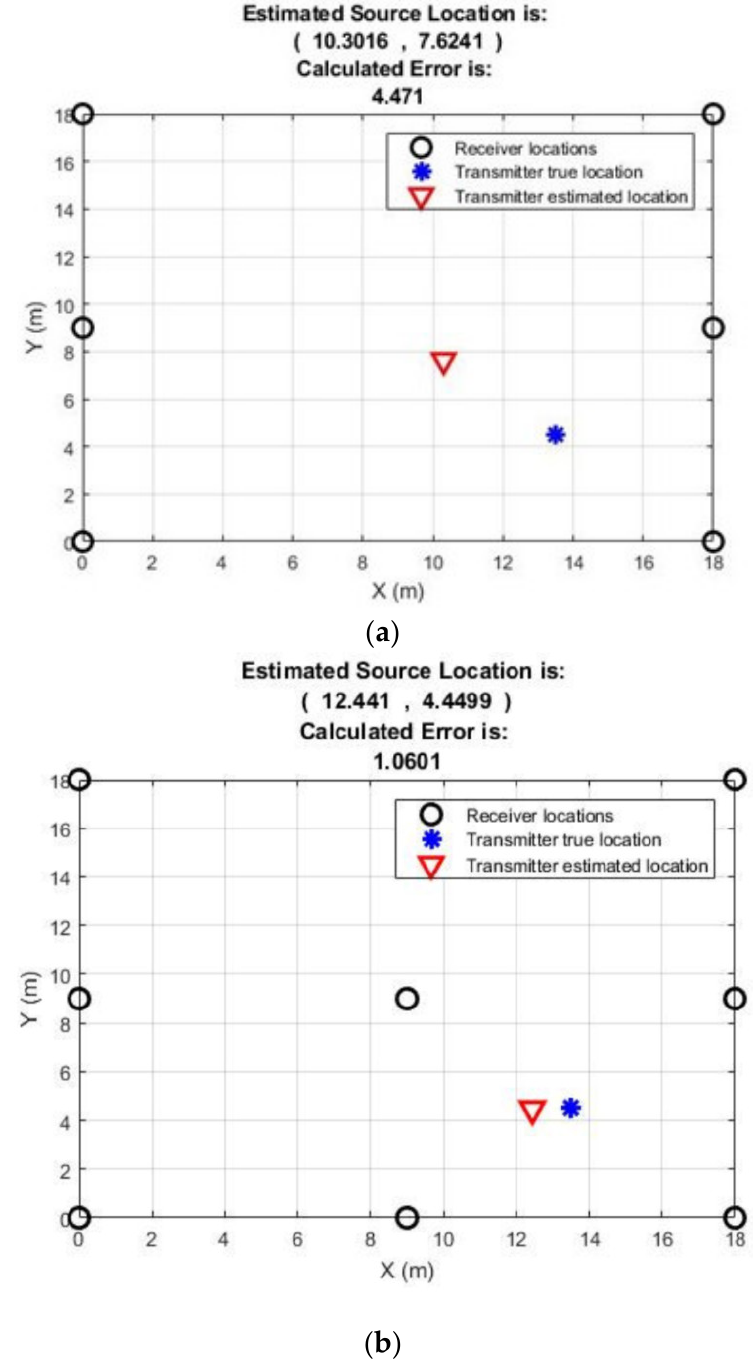
Figure 16. PD source detection using ( a ) six sensor nodes and ( b ) eight sensor nodes, [75].